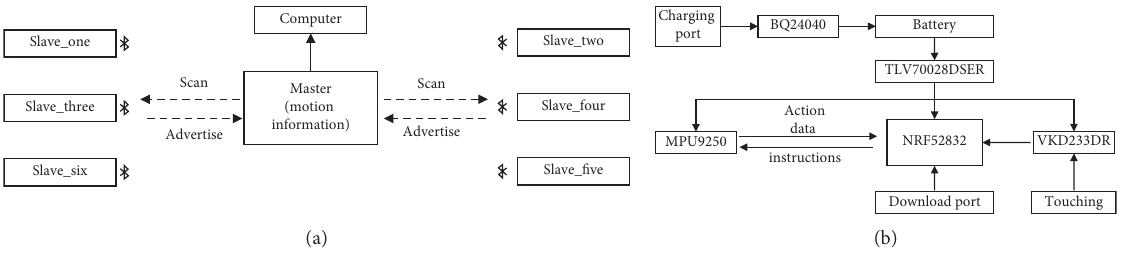
Figure 1: (a) Overall system structure and (b) sensor circuit block diagram.